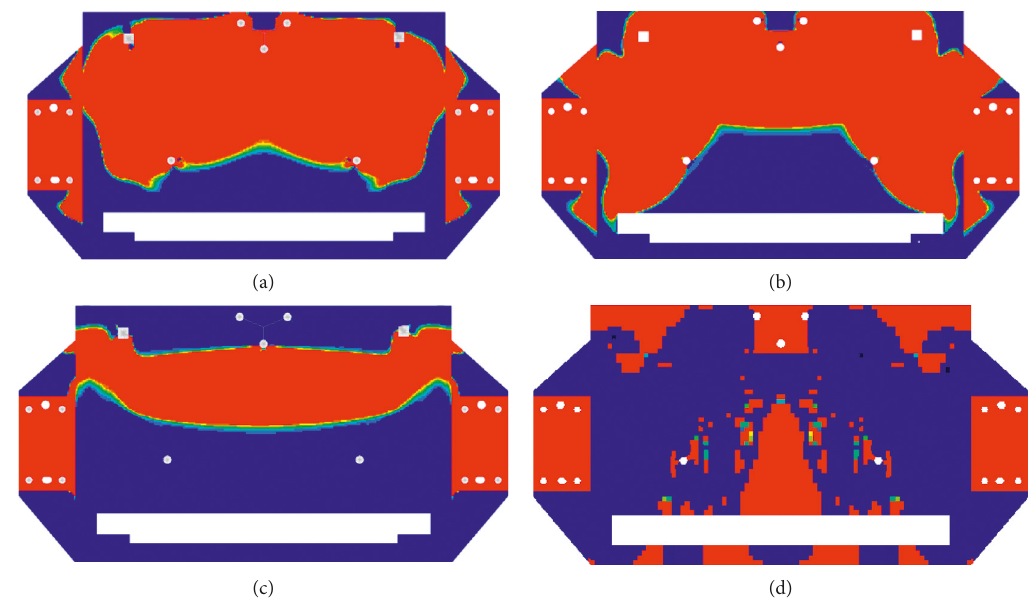
Figure 2: Topology optimization results. (a) Optimization results in the minimum flexibility of the latch limit tension condition; (b) optimization results in minimum flexibility of pedestrian protection impact force conditions; (c) optimization results in the minimum flexibility of the force conditions in the cushion area; and (d) optimization results in the first three sections of intrinsic frequency normalized weighted